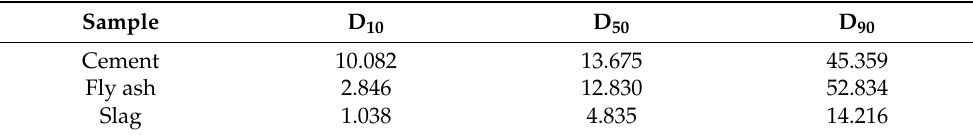
Table 2. Particles size distribution of cement, fly ash, and slag ( µ